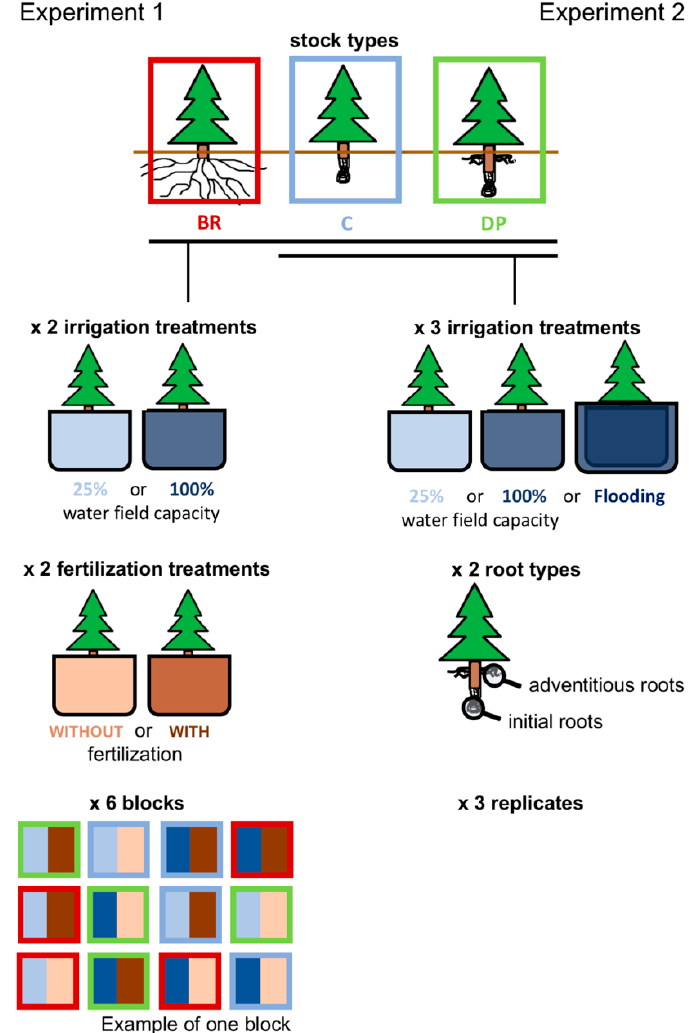
Figure 1. Greenhouse experiments using four-year-old black spruce seedlings. Experiment 1 consisted of three stock types: BR, bareroot seedlings (with an unrestricted root system, mainly composed of initial roots); C, containerized seedlings (with a restricted initial root system); and DP, deeply-planted containerized seedlings (with initial and adventitious roots restricted in a root plug). These were subjected to two irrigation treatments (maintenance of 25% or 100% water field capacity) and two fertilization treatments (with or without fertilization), replicated six times in a factorial design. Experiment 2 consisted of C and DP seedlings subjected to three irrigation treatments (maintenance of 25% or 100% water field capacity, or flooding condition). Cell morphology was observed for initial and adventitious roots (initial roots only for C seedlings) on three replicates per treatment.